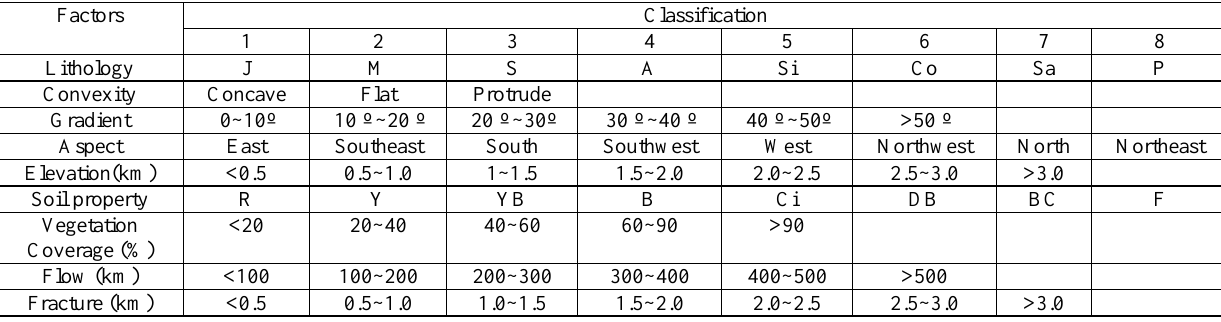
Table 2. Evaluation factors and